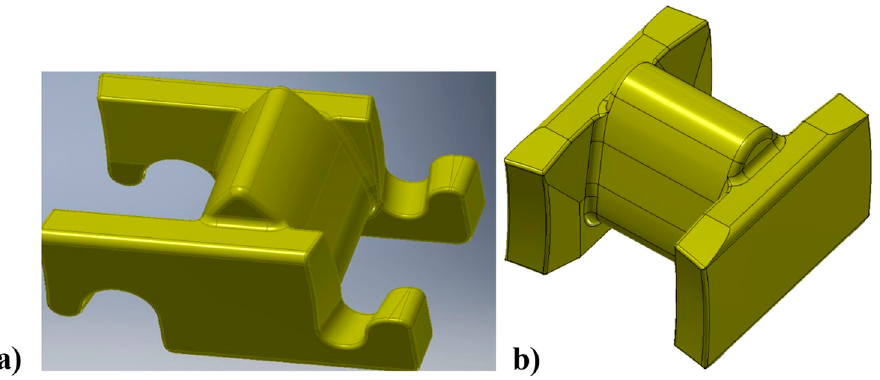
Figure 20. Three-dimensional model of the Komtrack toothed segment: ( a ) used in the field tests, ( b ) in the modernized version.